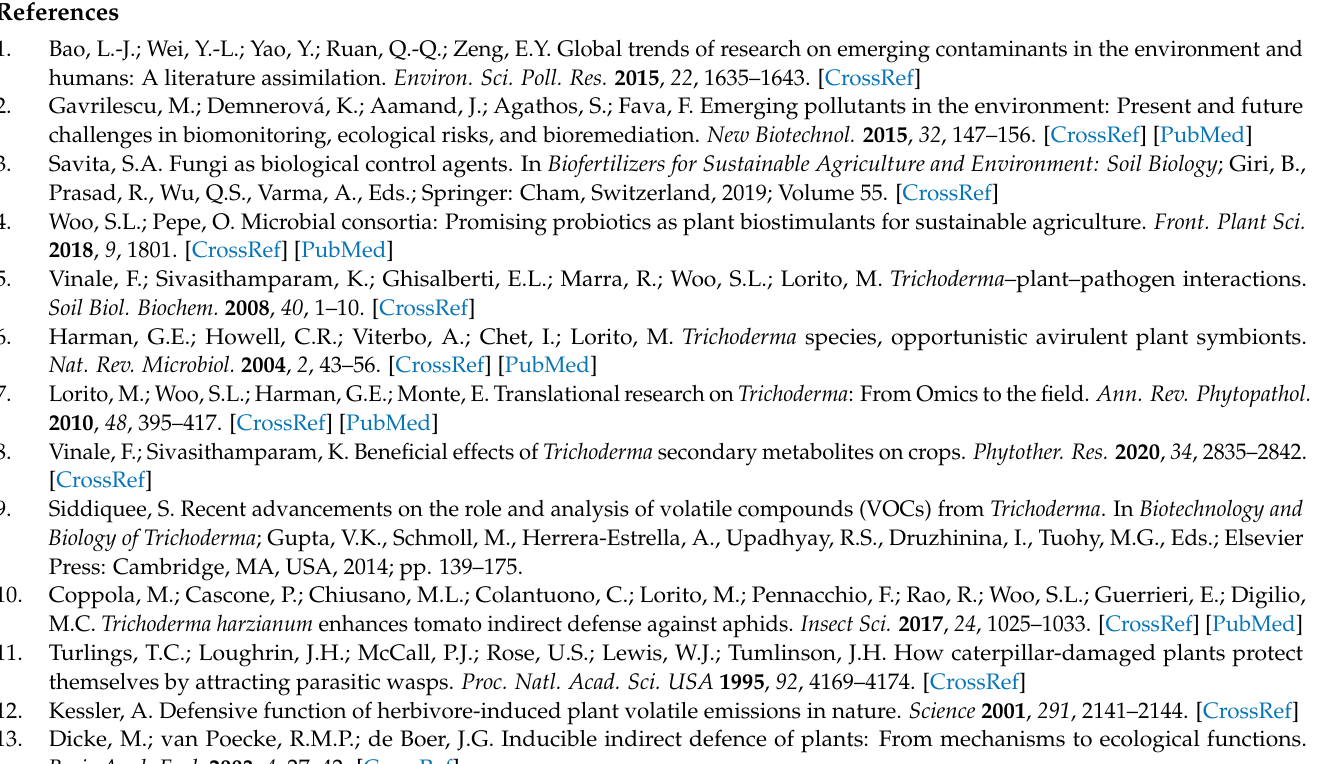
Figure S1: Example of an integrated gas chromatogram resulting from the extraction of plant VOCs sampled by Radiello®cartridges, Figure S2: Randomized block design of field experiment, Figure S3: Application of the Radiello®cartridges to olive